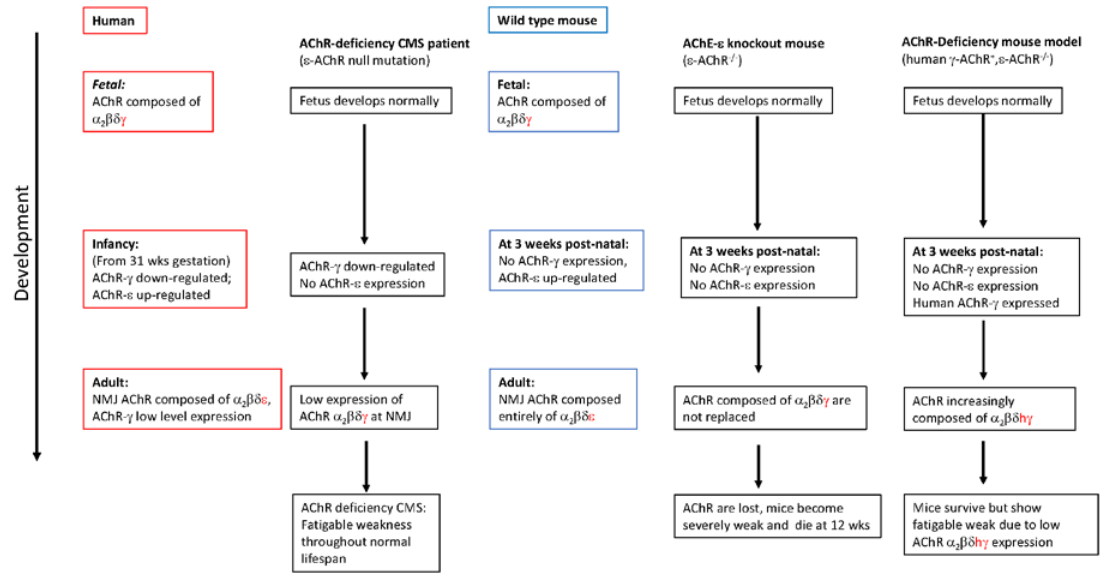
Figure 2. Diagrammatic representation of the developmental changes in AChR composition in humans and mice. Differences between human and mouse expression of ε - and γ -AChR are highlighted and consequences for AChR-deficiency CMS patients and mouse models of AChR- deficiency are compared. Mouse model expressing human γ -AChR in ε -AChR knockout background provides robust model of human CMS